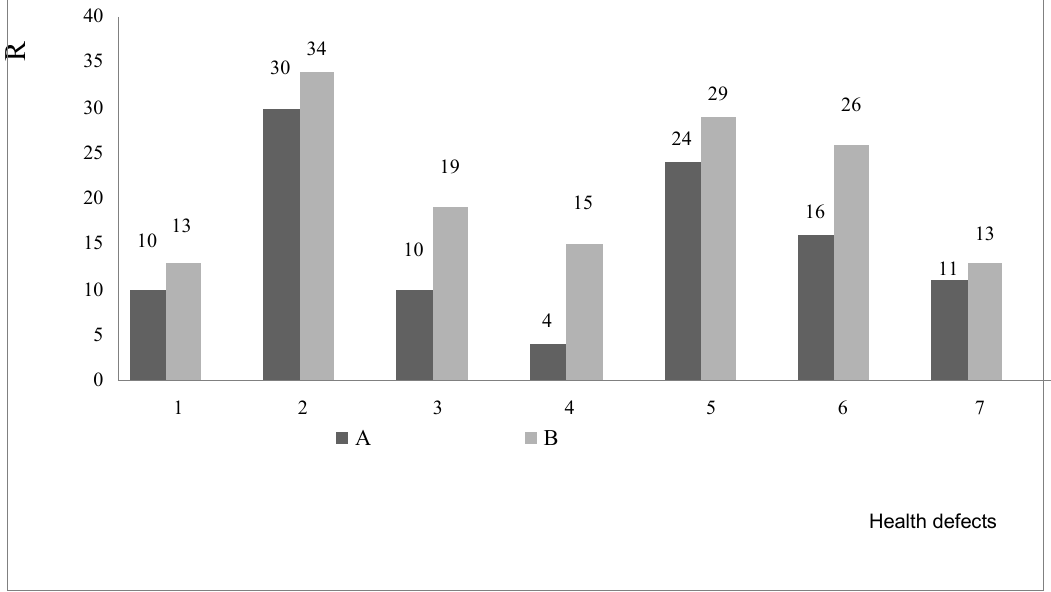
Fig.2. Output level of physical fitness of students with different nosologies (T.Yu. Krutsevych). Legend: R – physical health level; 45-5 high level; 35-44 – above average level; 24-34 points – average level; 15-24 below average level; 10-14 points – low level. 1 – eyesight; 2 –hearing; 3 – muscular-skeletal apparatus (MSA); 4 – cerebral palsy (CP); 5 – somatic diseases (SD); 6– diabetes (D); 7. – control group (CG); A - students; B –girl-